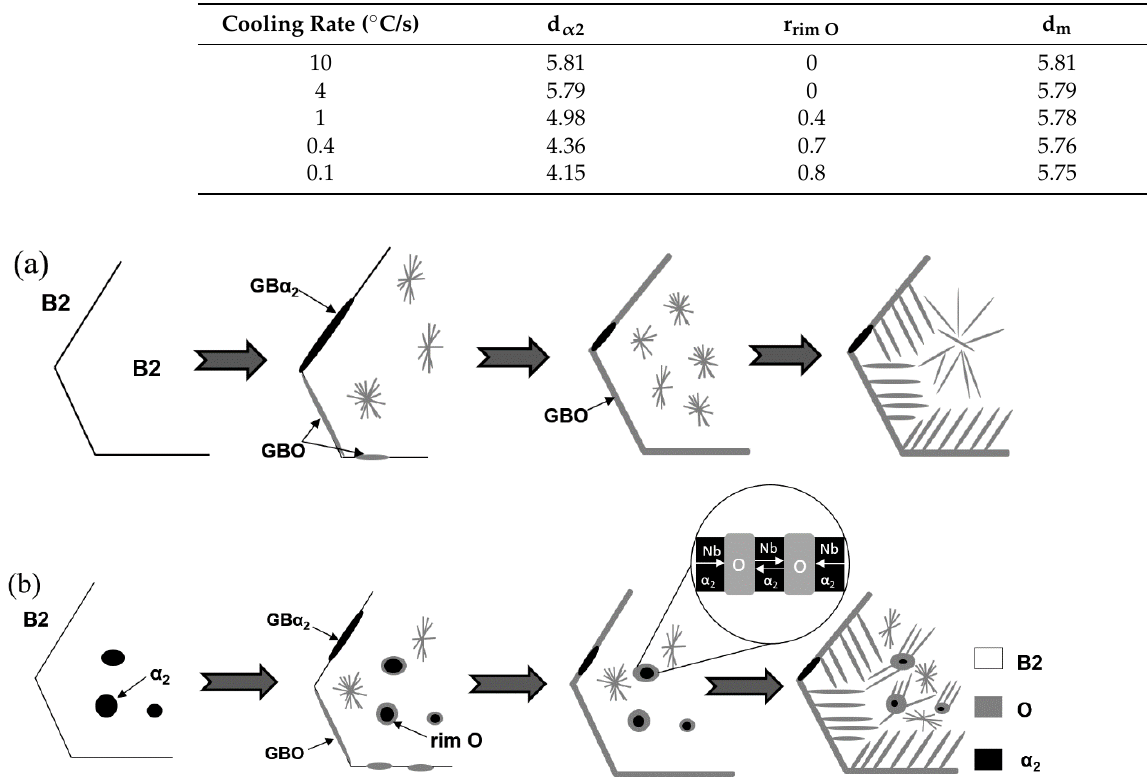
Figure 12. The schematic of the formation process of precipitated O phase with cooling from ( a ) B2 region, ( b ) B2 + α 2 region.